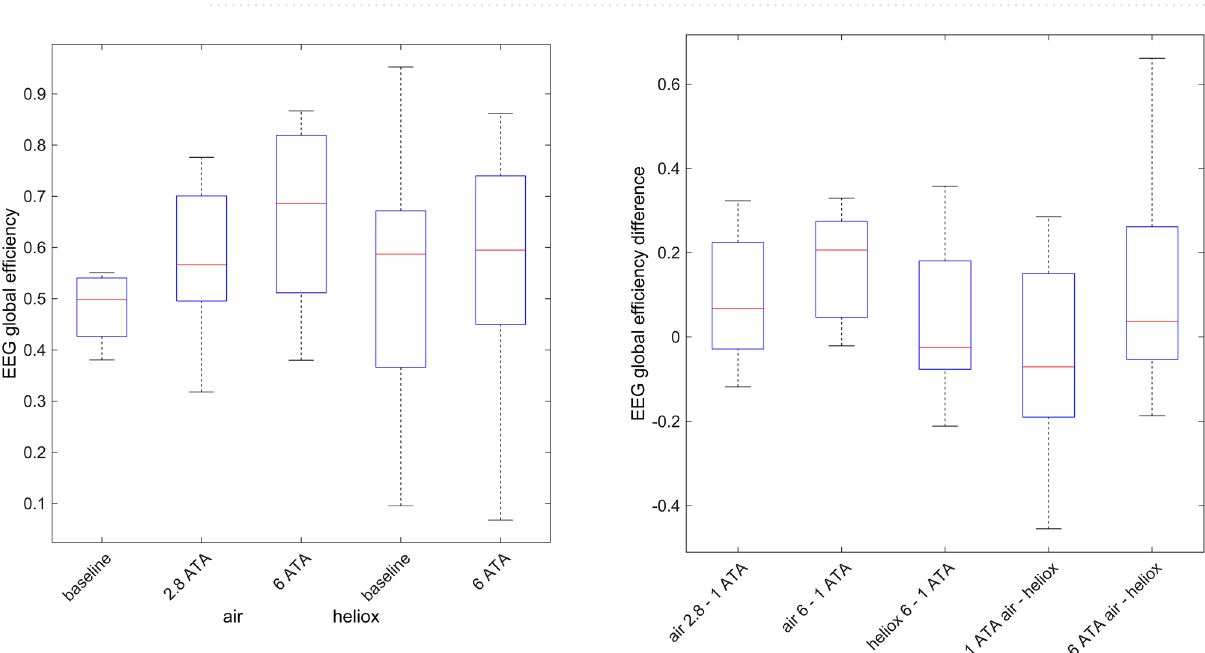
Figure 4. Box plot of the EEG mutual information based global efficiency metric (left) and the differences between exposures (right). The box plot shows the median (red line), interquartile range (blue box) and the whiskers showing the full range of the